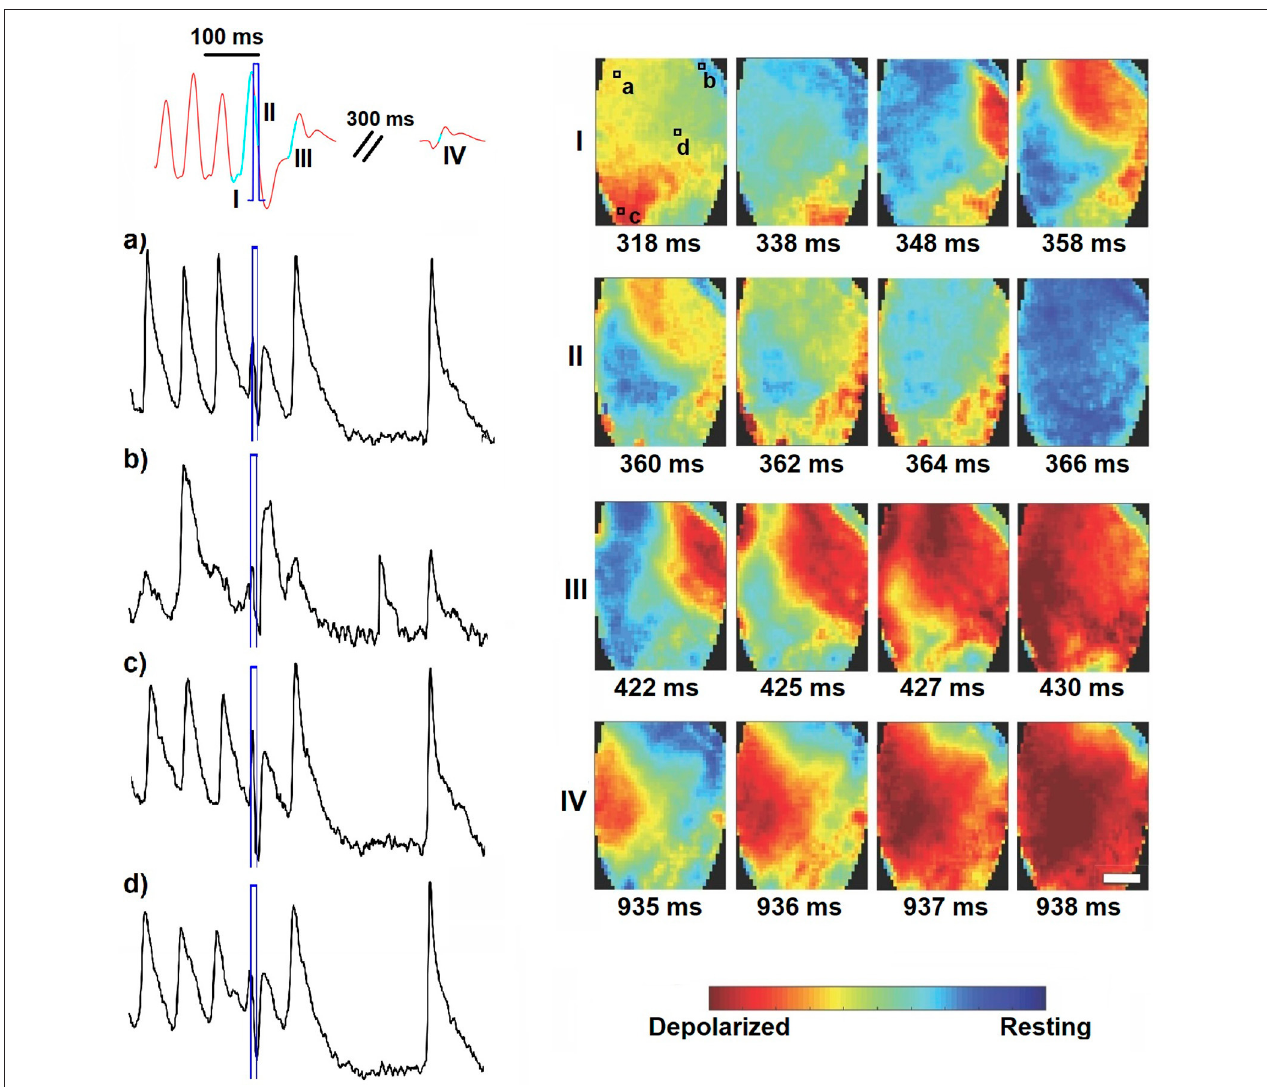
FIGURE 5 | Wave dynamics during short global light pulse (10ms, 0.25mWmm − 2 , highlighted in blue). Shown are the MAP recording (in red) and optical traces of several local spots on the ventricles (in black, as indicated in panel I). Optical mapping analysis revealed vortex-like electrical activity on the heart surface (image sequence I), which is disturbed by global illumination (image sequence II) and thus provoking wave collision resulting in annihilation (image sequence III). Sinus activity follows after a peak corresponding to depolarization of the whole heart (image sequence IV). The corresponding movie is available as ( Supplementary Material Movie 2